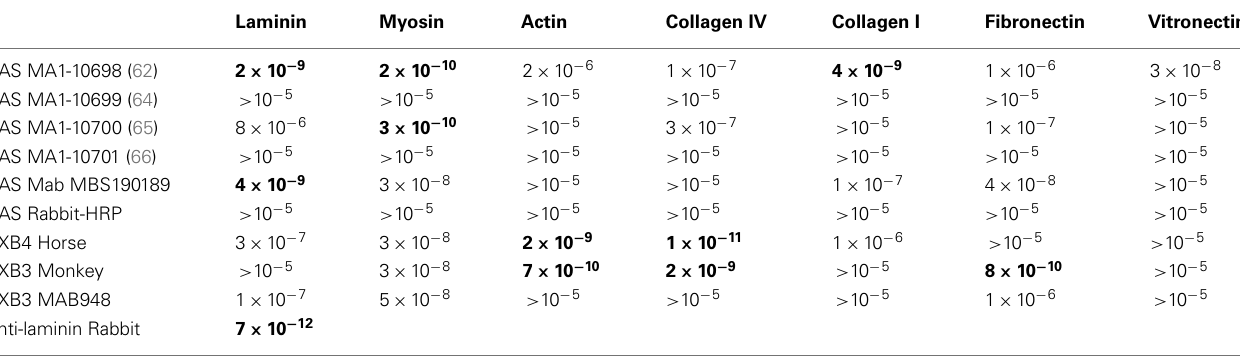
Table 3 | Results of ELISA experiments involving GAS (groupA streptococcus) and CX (coxsackie virus) antibodies binding to the proteins listed along the top